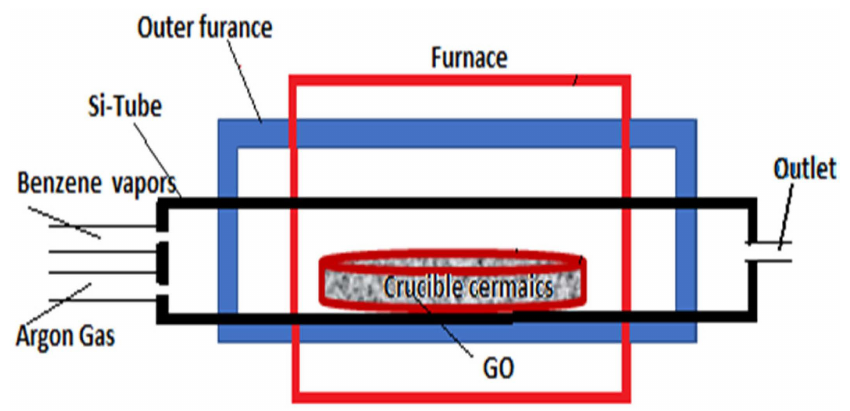
Scheme 1. Functionalized graphene oxide